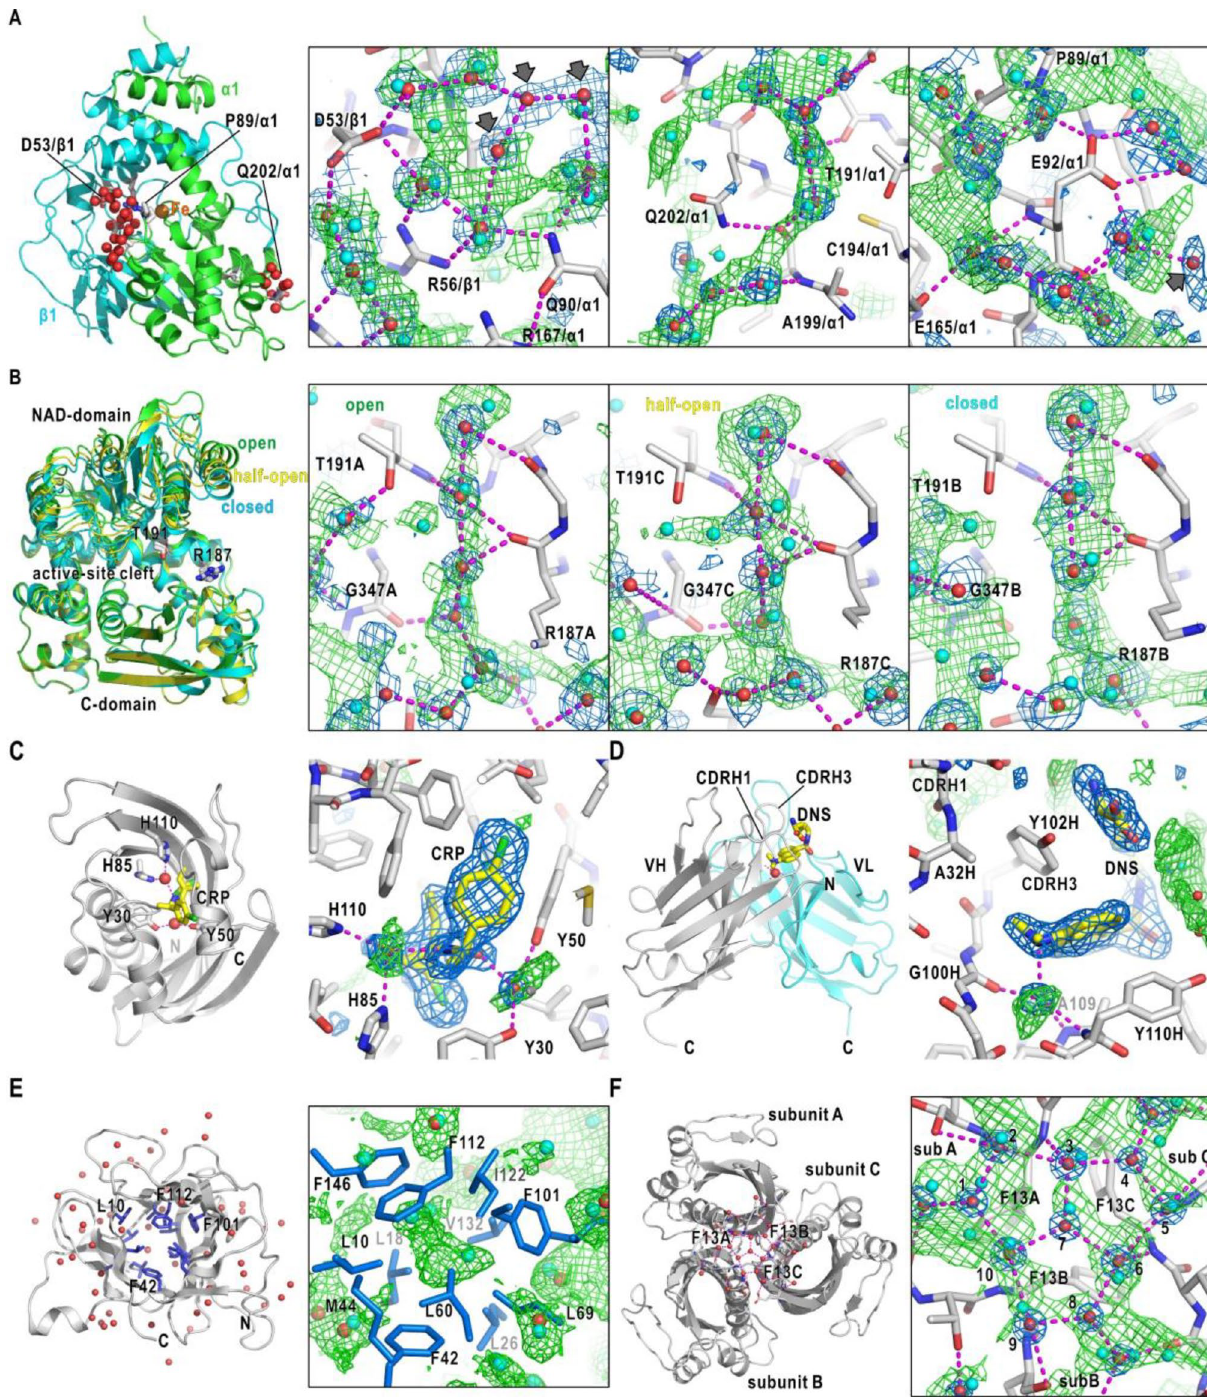
Figure 4. Predicted probability distributions for clusters of hydration water molecules in the first-layer class. ( A ) Prediction for three clusters of hydration water molecules of NHase. ( B ) Prediction of columnar arrangement of hydration water molecules in the open, half-open, and closed states in the NAD-domain motion to open/close the active site cleft in GDH subunits. The locations of Arg187 and Thr191 are shown in the left panel. ( C ) Whole structure of SDH subunit in complex with its inhibitor, carpropamid (CRP) (the accession code of PDB: 2std) (left panel) and a magnified view of the inhibitor moiety in the active site pocket (right panel). ( D ) Whole structure of the anti-dansyl Fv fragment (the accession code of PDB: 1wz1) (left panel) and magnified view of the binding-site. In panels ( C ) and ( D ), blue nets are omit-difference Fourier maps of ligand molecules and hydration water molecules mediating protein–ligand interactions contoured as Fig. 2A. ( E ) Probability distribution in a hydrophobic pocket located at the center of IL-1β (the accession code of PDB: 9ilb). ( F ) Prediction of a cluster of three pentagonal arrangements on a hydrophobic surface of trimeric Phe162Ala- mutated SDH (the accession code of PDB: